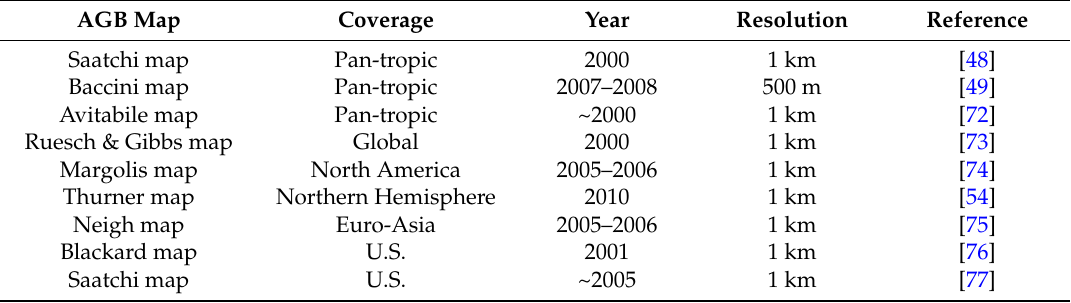
Table 2. Main characteristics of the AGB maps used for the comparison in this study. AGB Map Coverage Year Resolution Reference Saatchi map Pan-tropic 2000 1 km Baccini map Pan-tropic